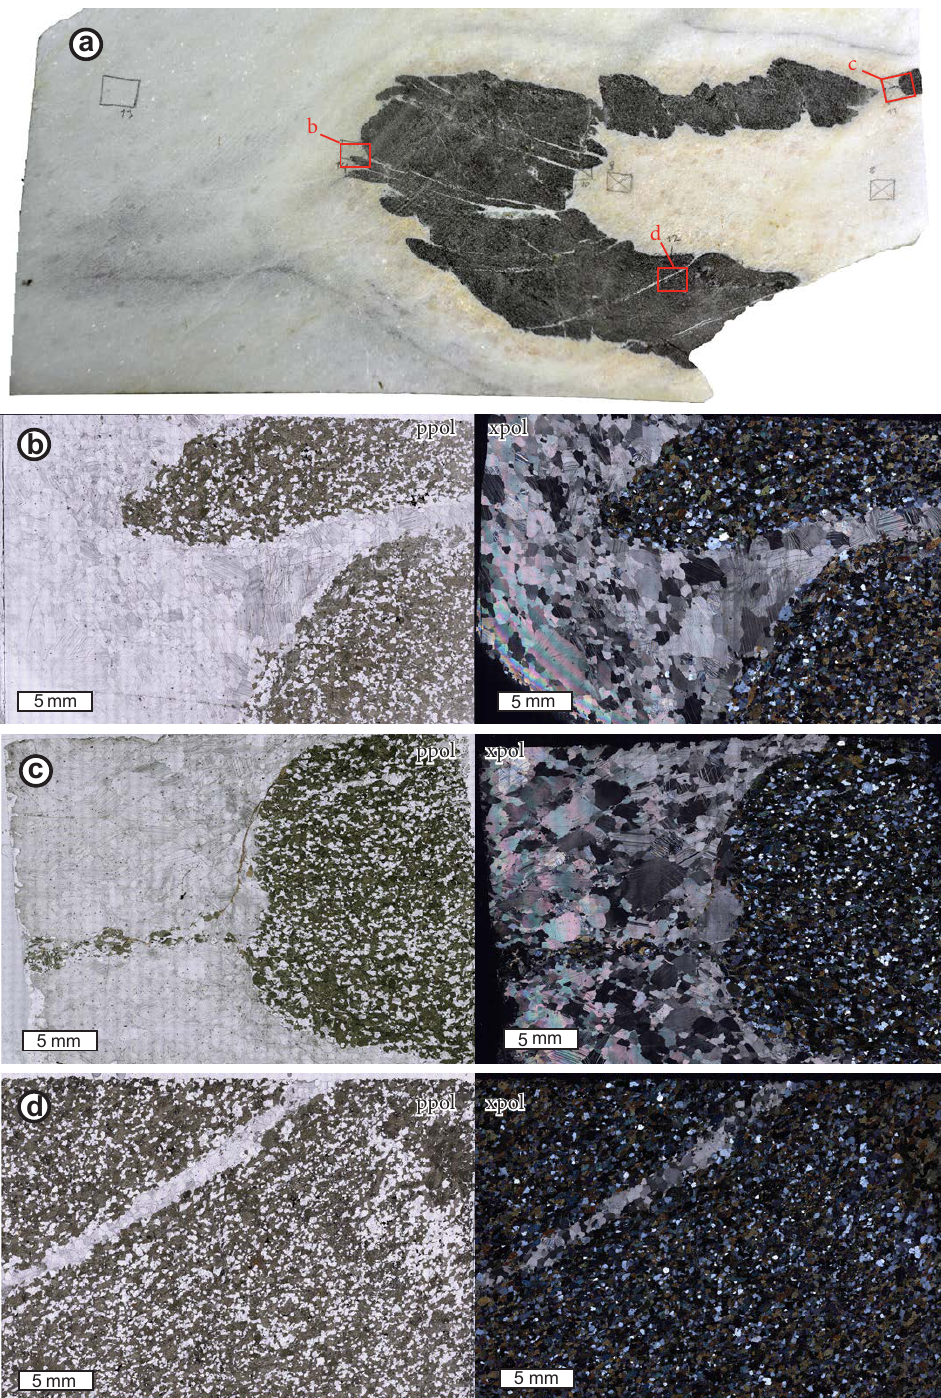
Figure 11. (a) Sample of a folded amphibolite layer. Red boxes show the thin section locations (b–d) . Each section is shown in plane- polarized light (left) and cross-polarized light (right). (b) Cuspate–lobate structure in the fold hinge. Although significant deformation can be expected in the lobes, the amphibolite shows no evidence of dynamic recrystallization. (c) Biotite wraps around the interface of the amphibolite and into the pinched neck of this boudin. (d) The calcite inclusions in the fold hinge contain fragments of amphibole and indicate boudins prior to folding. The calcite grain size in the inclusions is consistently smaller than in the marble.